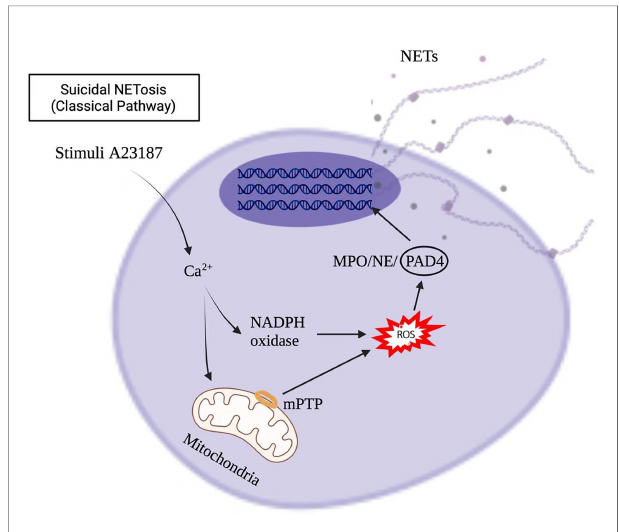
FIGURE 2 | Calcium ionophore A23187 induced NETs formation in the suicidal